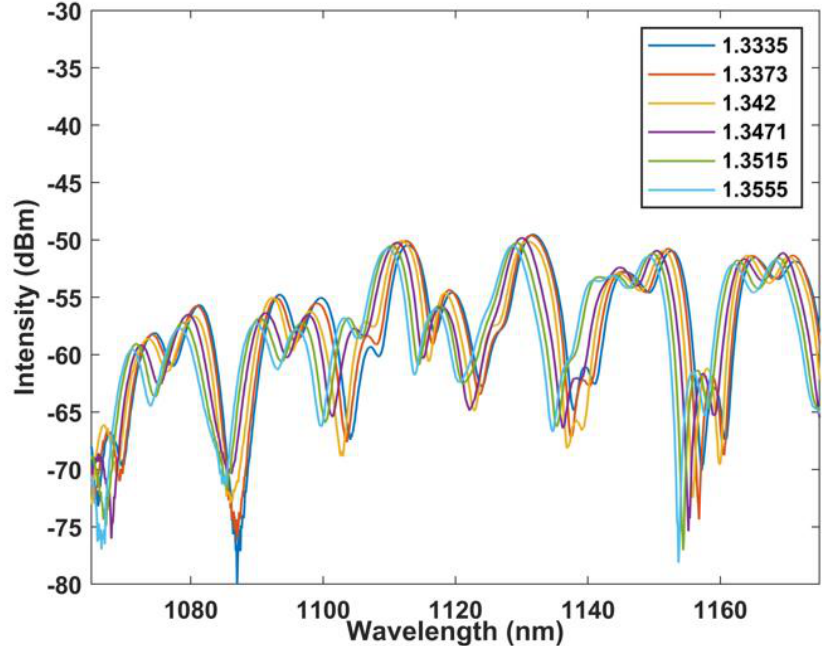
Figure 11. Wavelength versus RI curve at BBS.